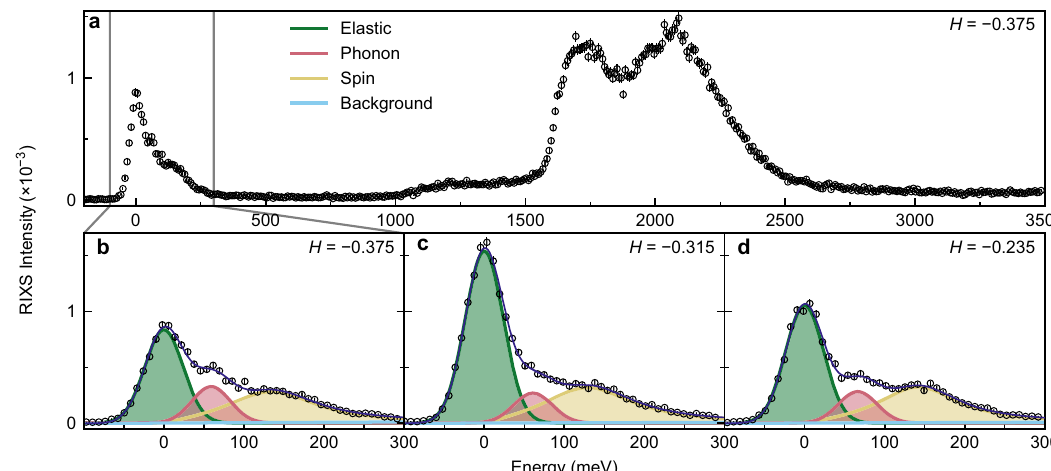
Fig. 1 RIXS spectra. a RIXS spectra of the p = 0.25 sample taken at 45K showing dd excitations near 2000 meV. b – d The low-energy region of the RIXS spectra, can be fi tted with three components comprising elastic scattering including the CDW, phonon and paramagnon spin excitations (see Methods). The elastic scattering is strongest at H = − 0.315 where the CDW is present. We label reciprocal space using Q = H a ⋆ + K b ⋆ + L c ⋆ , where ∣ a ⋆ ∣ = 2 π / a , a = b = 3.85 Å, c = 23.1 Å, and negative H implies grazing incident